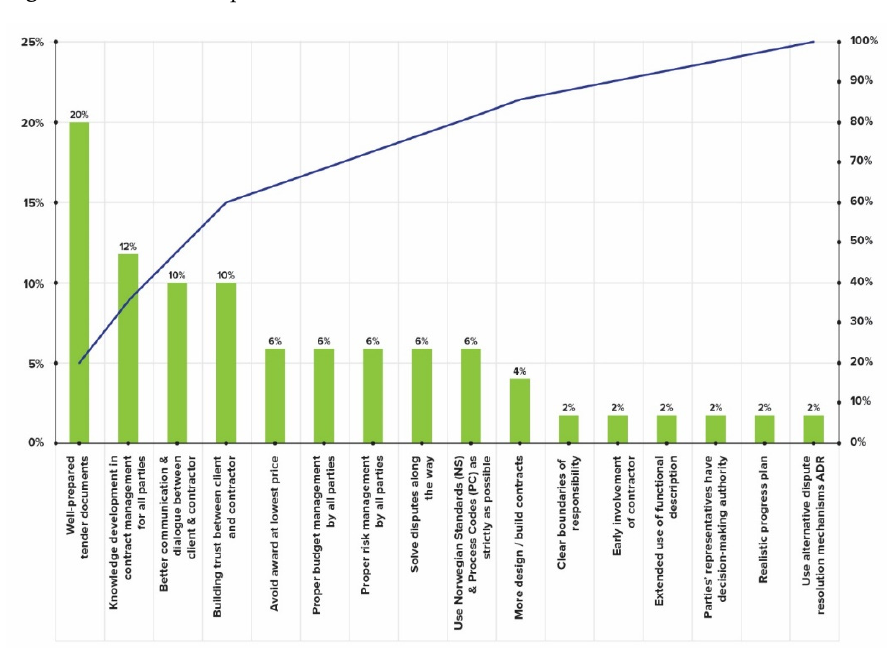
Figure 8. Pareto diagram showing disputes prevention techniques related to the tender specification and contract understanding.